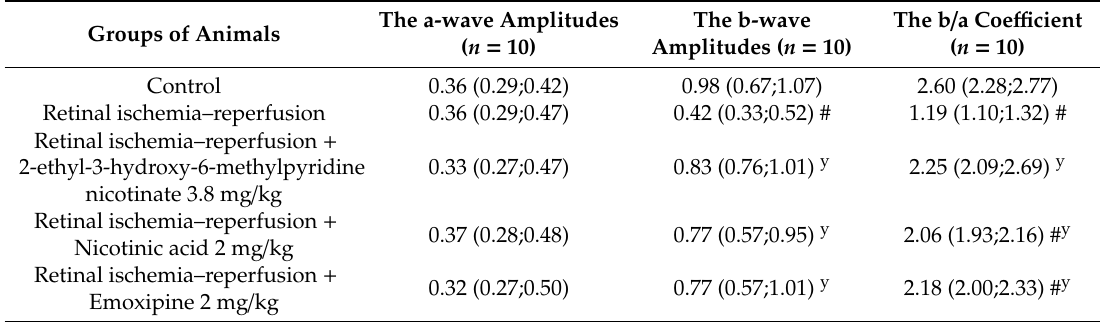
Table 1. Influences of 2-ethyl-3-hydroxy-6-methylpyridine nicotinate, nicotinic acid, and Emoxipine on the a- and b- wave amplitudes (mV) and the b / a coe ffi cient when correcting retinal ischemia–reperfusion (Me (Q L